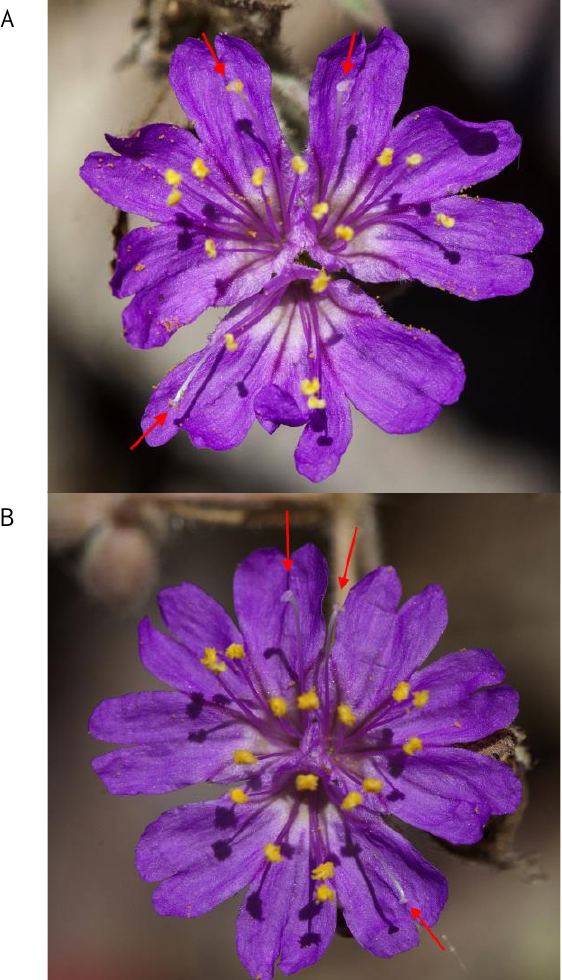
F IGURE 1. Photographs of Allionia incarnata L. (A) and (B) represent left- and right-handed blossoms, respectively. Each Allionia blossom consists of three zygomorphic flowers, each with an enantiomorphic style. Arrows point to styles, which are deflected either to the left or to the right. However, all three styles are generally not deflected in the same direction, resulting in two parallel styles and the third style pointing away from the other two. Styles are white tipped, making pollen visible with the naked eye as seen on the top- left style in (A). Photos by Bob